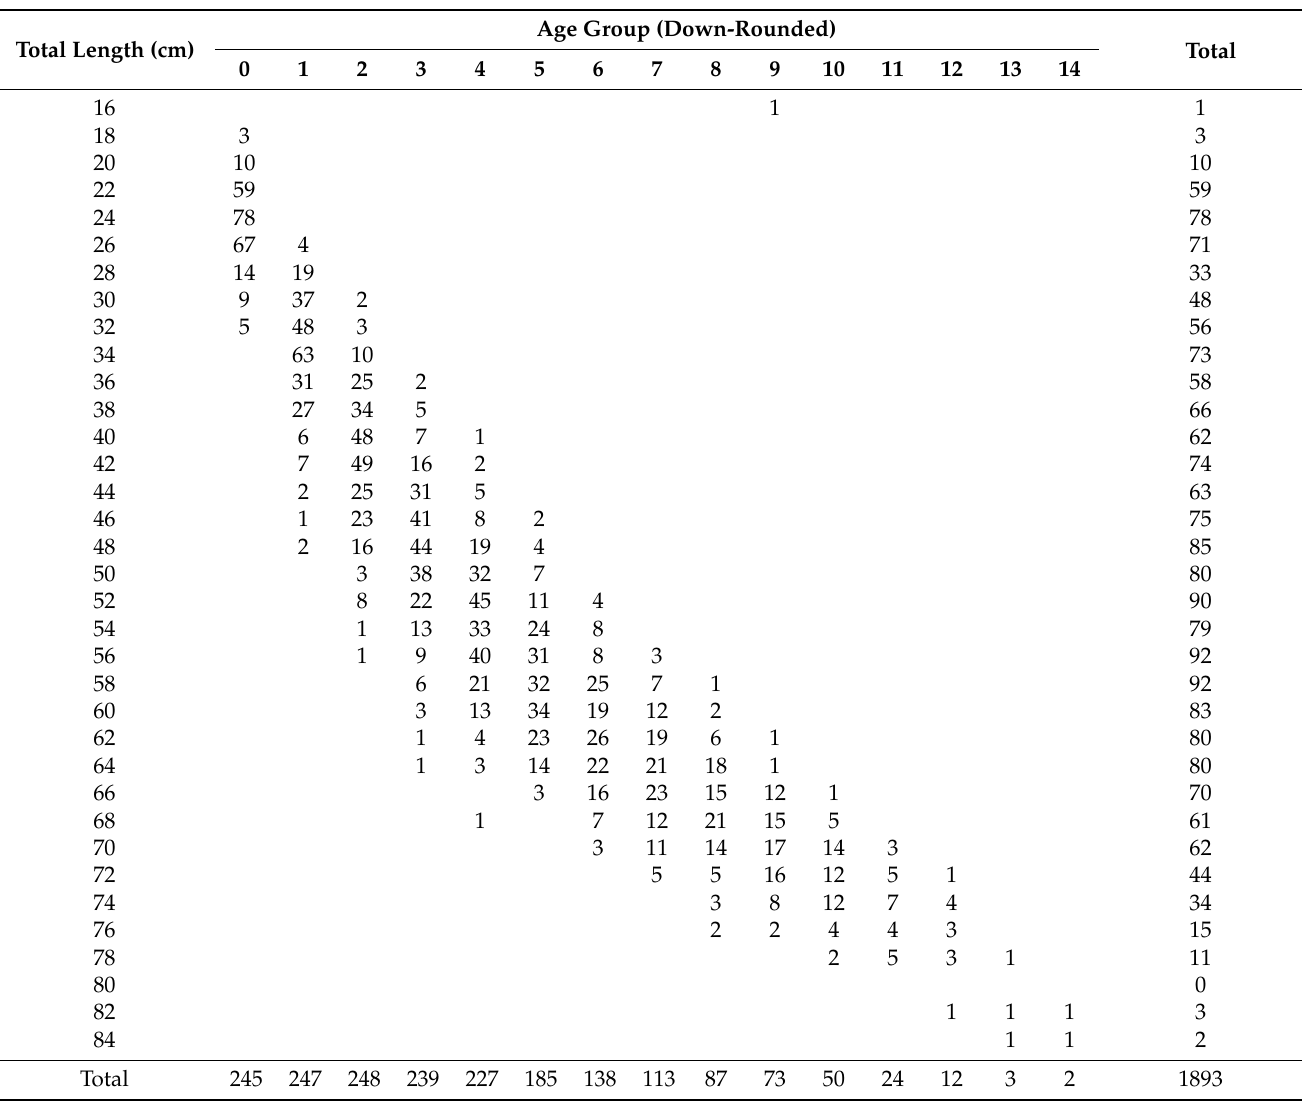
Table 3. Age–length distribution for Narcine entemedor obtained from growth band counts of vertebrae sections and back-calculated. Age estimation follows the age adjustment 2 (adjusted to reproductive cycle and date of